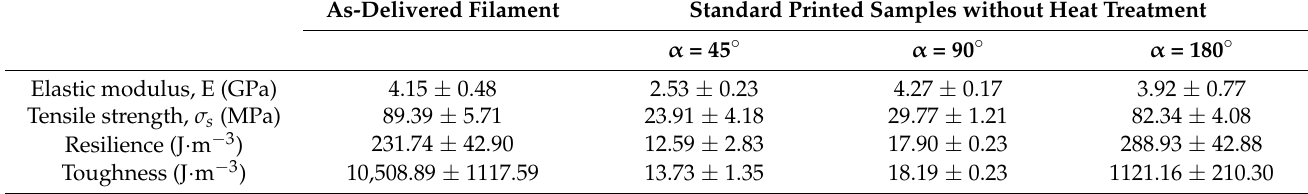
Figure 11. Results for ultimate strength and modulus of elasticity from tensile tests for as-delivered and extruded filament: ( a ) with heat treatment and ( b ) without heat treatment.